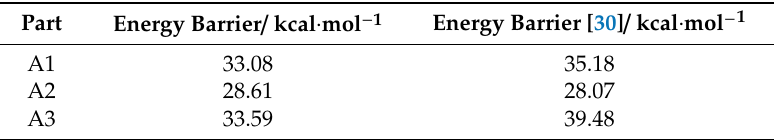
Table 1. Energy barrier comparison of the Part A1–A3.